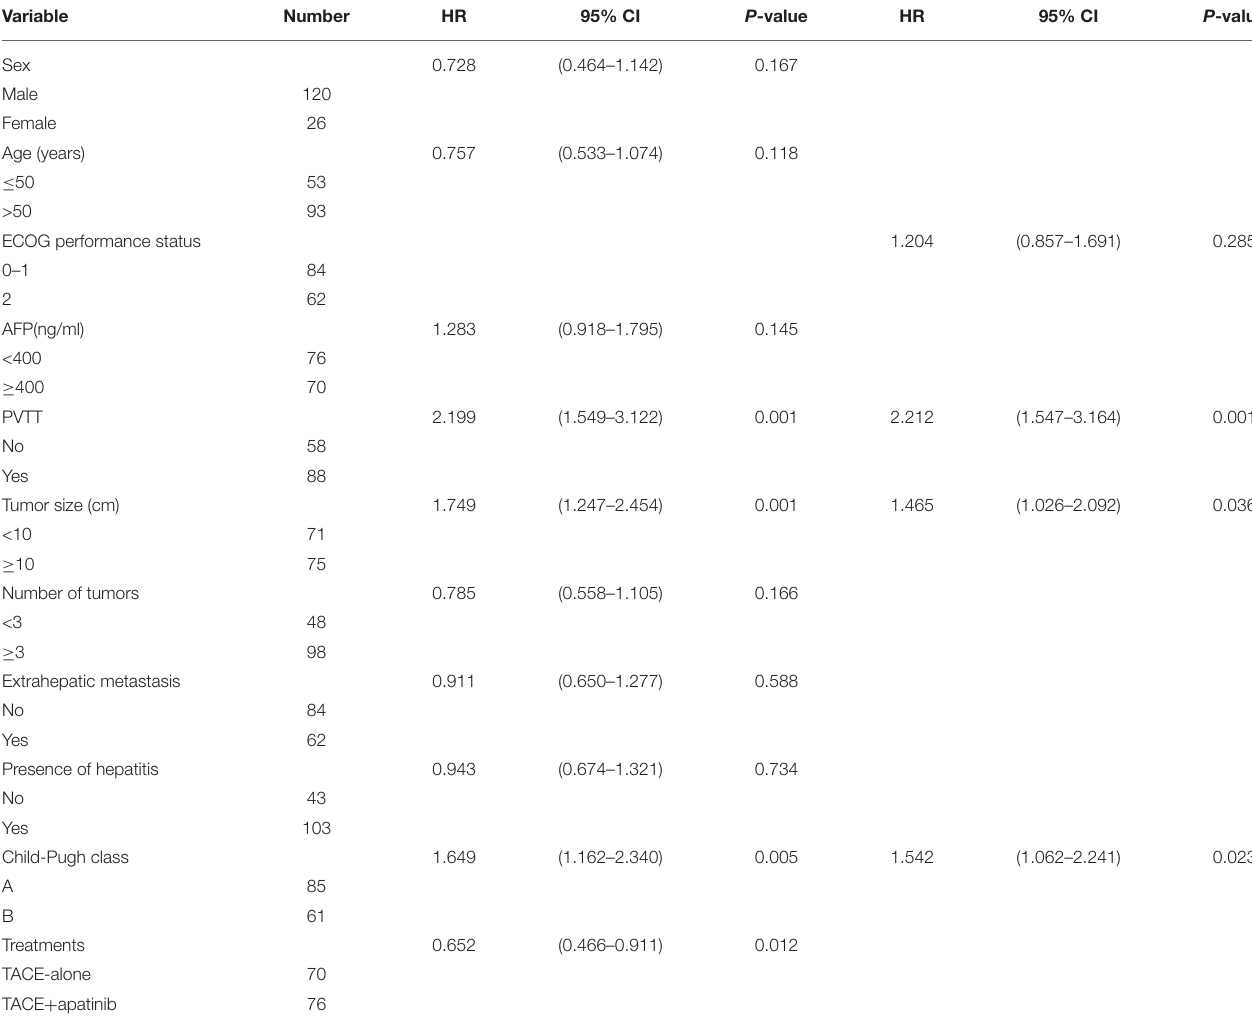
TABLE 3 | Univariate analysis and multivariate analysis of prognosis in patients with stage BCLC-C HCC.